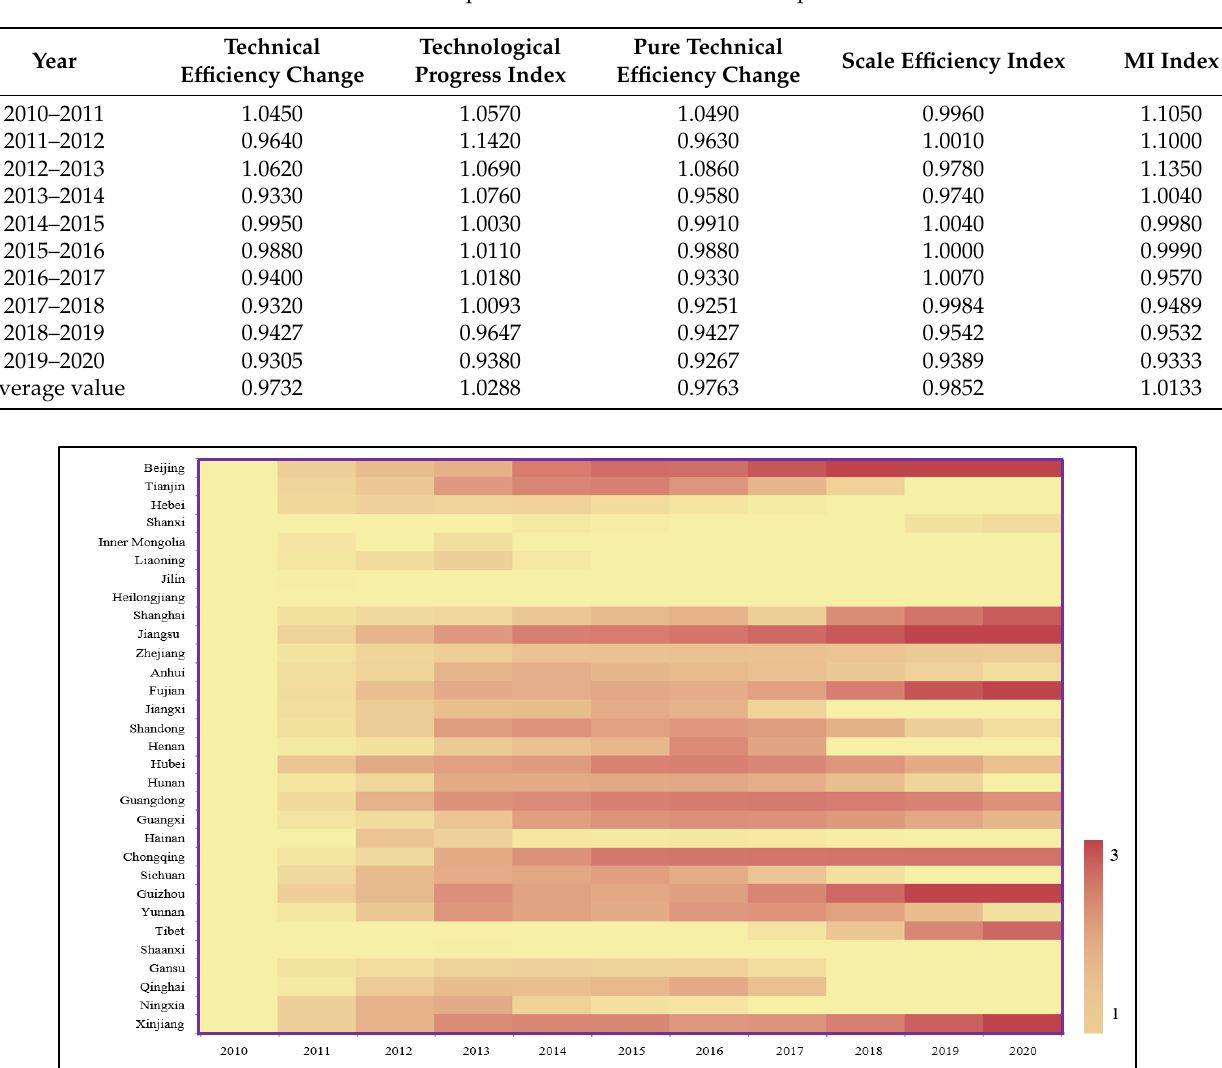
Figure 4. Heat map of the dynamic production efficiencies of the construction industry in 31 provinces in China.